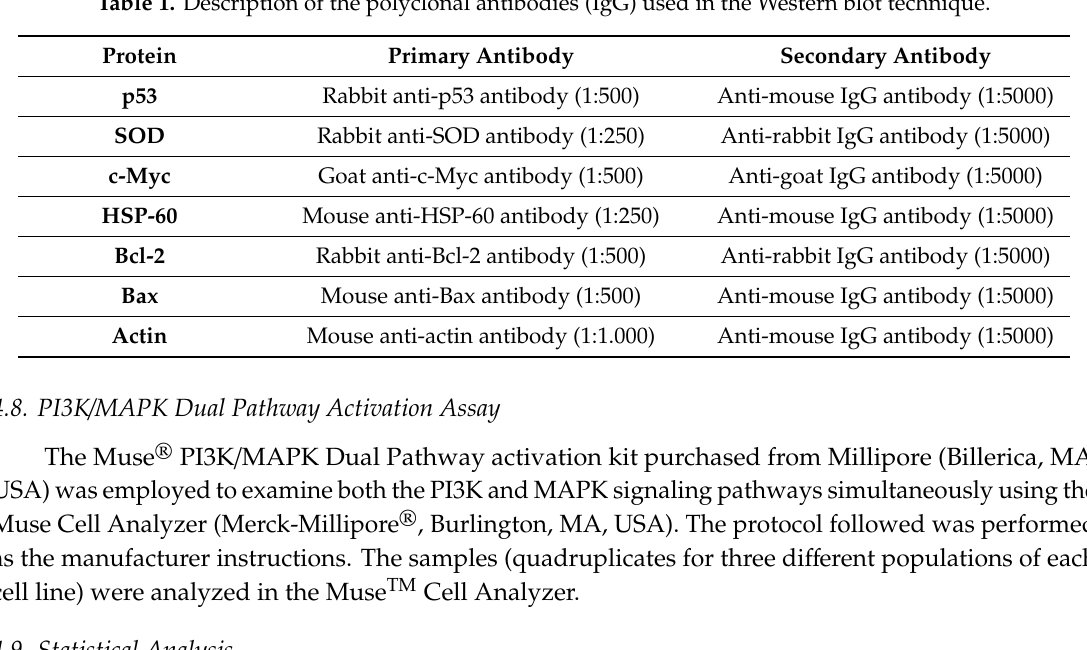
Table 1. Description of the polyclonal antibodies (IgG) used in the Western blot